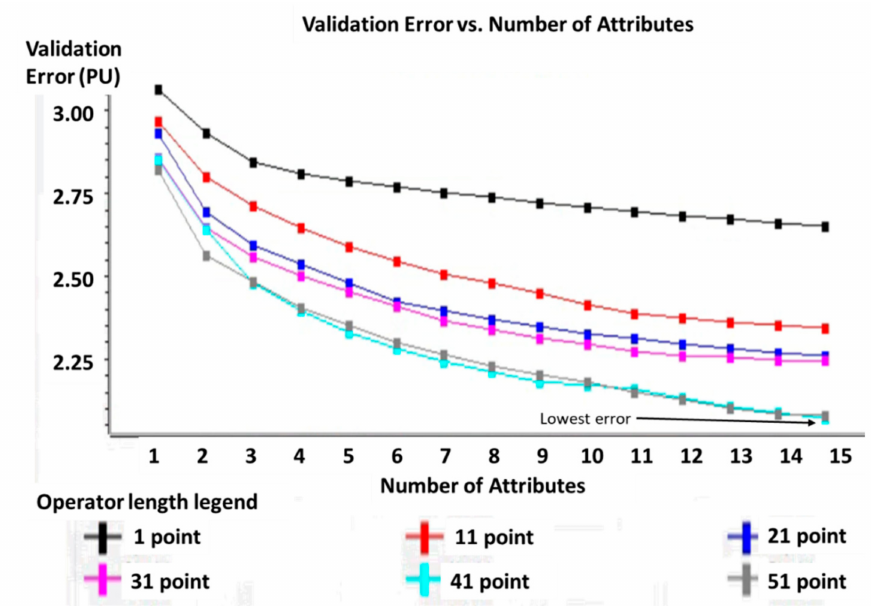
Figure 8. Average training error versus the number of attributes testing convolutional operator lengths from 1 to 51 samples every 10 points. The black arrow indicates the point of the lowest validation error achieved using a 41-point operator. The example shown corresponds to the Group 4 attribute selection process. As the sample rate is 1 ms, the 41-point operator represents 40